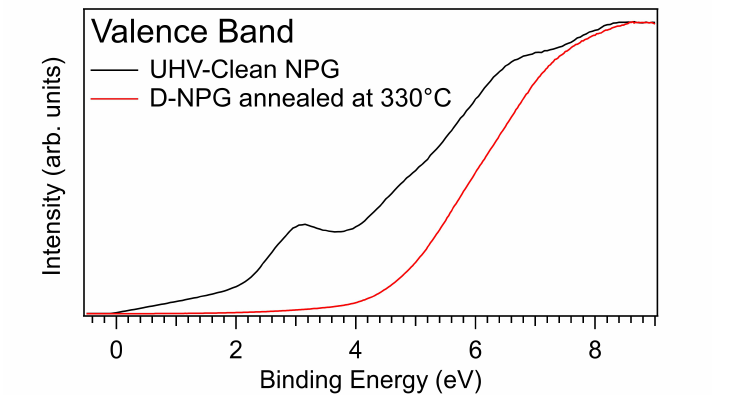
Figure 6. UPS valence band spectra (photon energy 21.218 eV) of UHV-cleaned NPG and of D-NPG annealed at 330 ◦